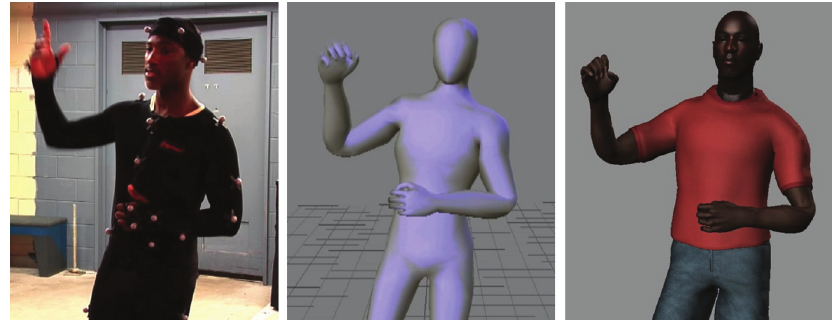
Figure 12. Motion-Capture Performance (Left), Character Template Data (Center), and Charac- ter Retargeting Data